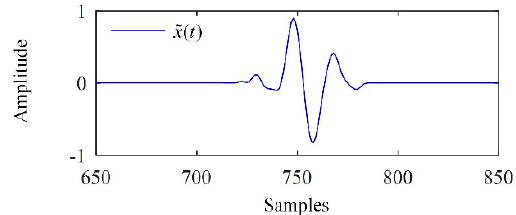
Figure 8. The denoised signal of the ultrasonic signal from F2.